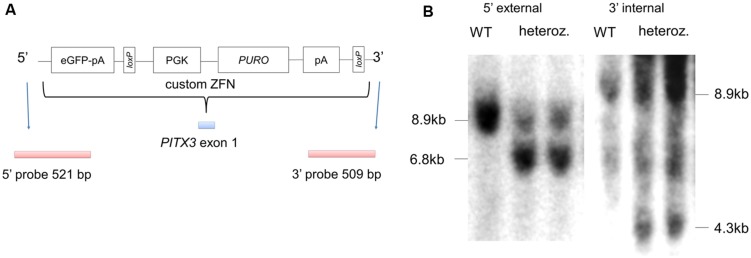
Targeting eGFP to the endogenous PITX3 locus in hPSCs using zinc finger nucleases (ZFN).
(A) shows a schematic of the donor plasmid for targeting eGFP to the endogenous PITX3 locus; the strategy employed was based on that reported by Hockemeyer et al. (2009). PGK, human phosphoglycerol kinase promoter; PURO, puromycin resistance gene; loxP, loxP sites; pA, polyadenylation sequence. (B) Correctly targeted colonies (as determined by PCR) were generated with 19% efficiency, and subsequently confirmed by Southern blot analysis (modified from Hartley et al., 2014).